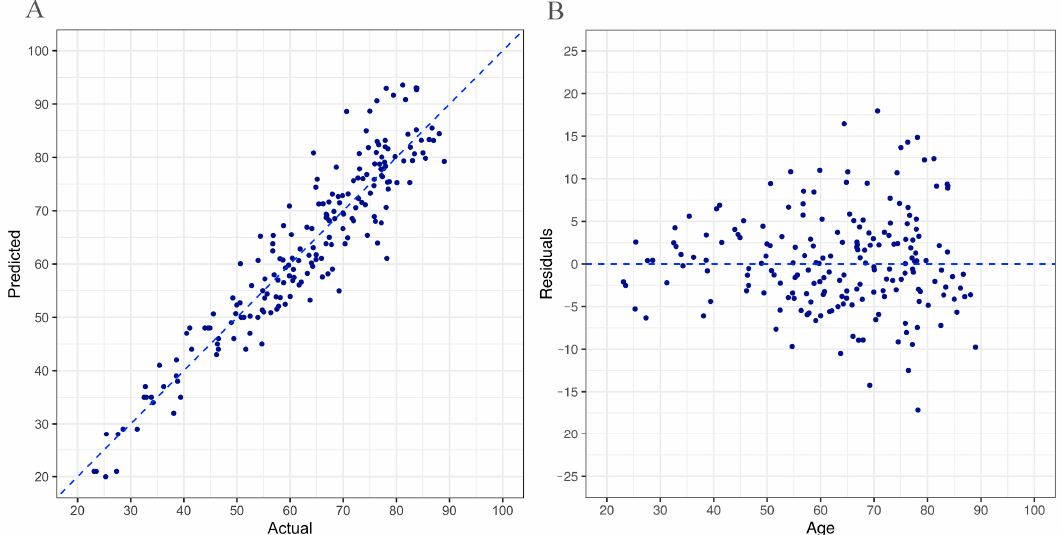
Figure 3. Age prediction from blood-derived DNA samples. ( A ) Linear regression of the relationships between human individual age and age predicted using the molecular clock in which ELOVL2 was used in combination with sjTREC (dotted lines correspond to 95% prediction interval). ( B ) Deviation of DNA methylation (predicted) age and chronological age (residuals) against the predicted age. The deviation in older individuals ( > 60 years old) was higher compared to younger ones. Linear and LOESS regression lines are reported in dashed red on the left and right panel,